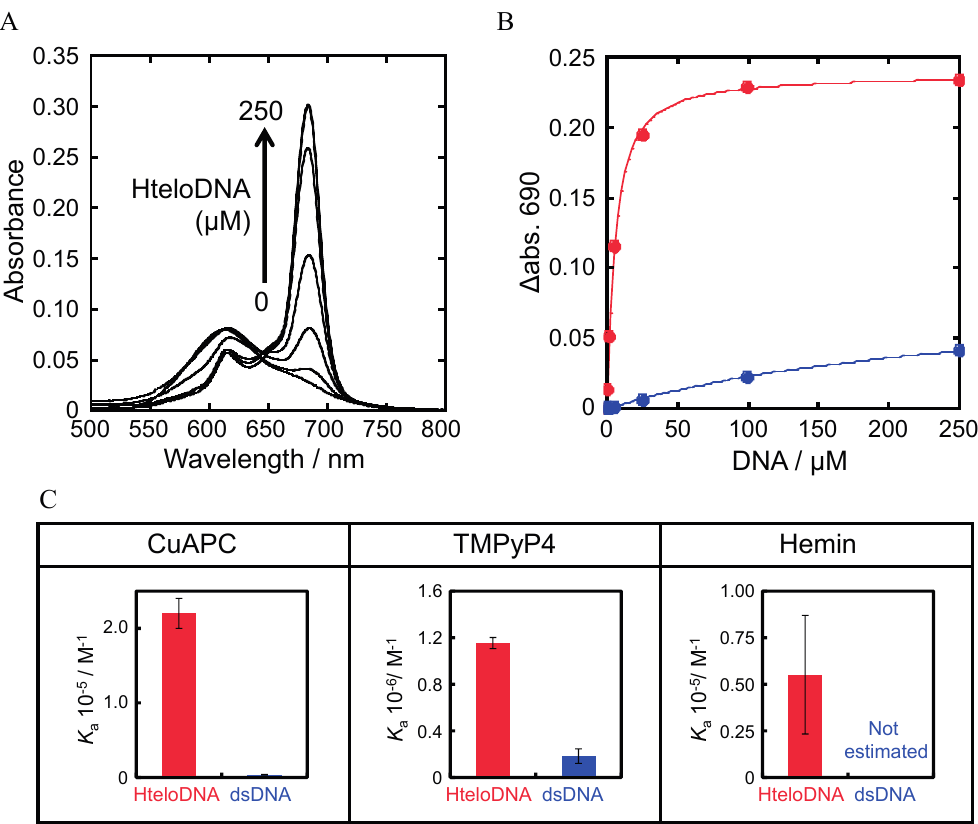
Figure 5. ( A ) Visible absorbance spectra of 2.5 µM CuAPC with 0–250 µM of HteloDNA at 25 °C. The sample was first heated at 80 °C for 2 min, then gently cooled at 2 °C·min − 1 ; ( B ) Absorbance of 2.5 µM CuAPC at 690 nm with 0-250 µM of HteloDNA and dsDNA (5'-AGAAGAGAAAGA-3'/5'-TCTTTCTCTTCT-3'); ( C ) K a value of each ligand